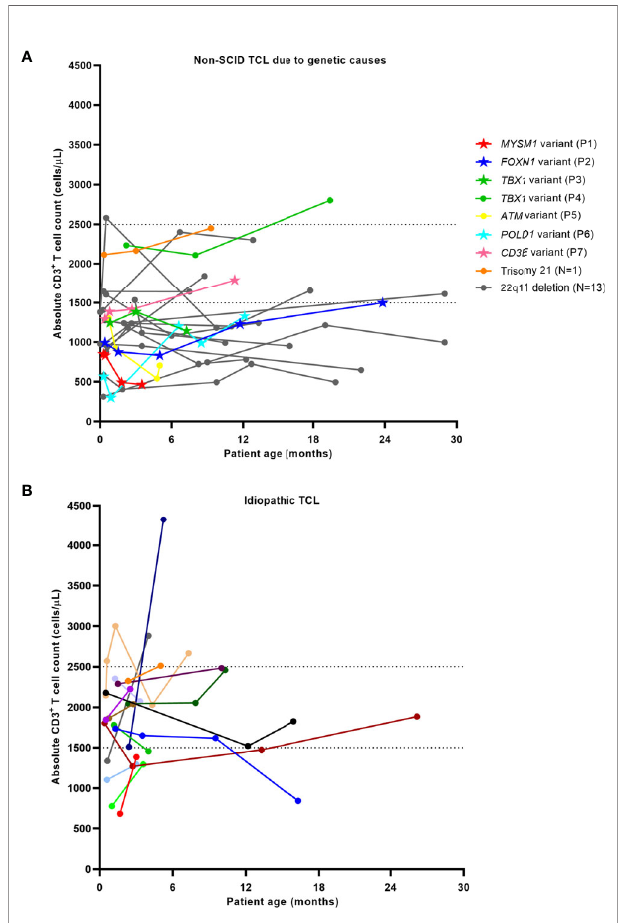
FIGURE 2 | T lymphocyte trends in patients with non-SCID TCL due to genetic causes (A) and idiopathic TCL (B) . Dashed lines indicate cutoffs for mild (1500-2500 cells/ m L) and moderate (300-1500 cells/ m L) TCL. Data sets represented by stars in Figure 1A indicate the patients with novel pathogenic variants at the time of diagnosis.